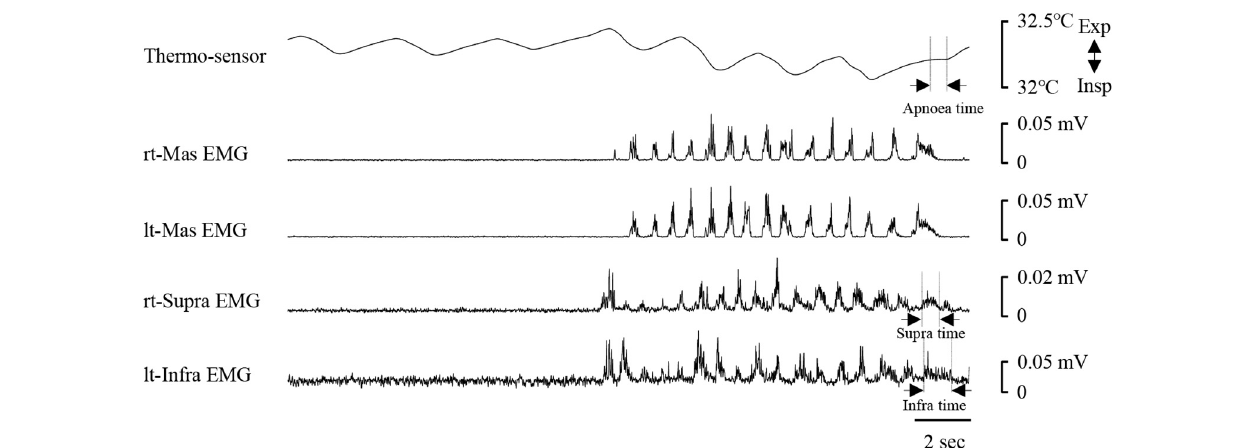
FIGURE 8 | Example of respiratory and electromyography (EMG) recordings during chewing. EMG waveforms were rectified and smoothed. Note that the respiratory cycle time decreased once mastication started. The coordination pattern of respiratory and swallowing was expiration–swallow–expiration type. Periods of